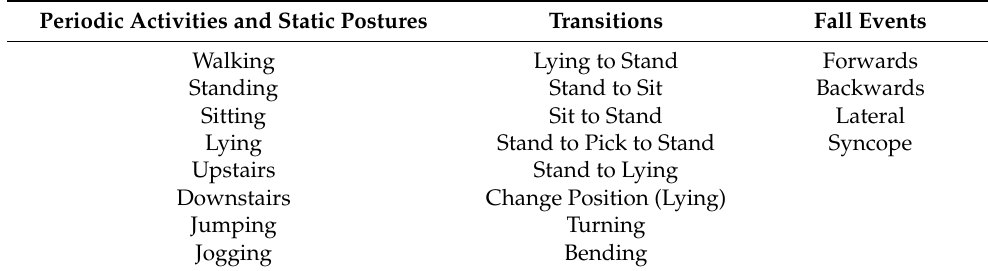
Table 3. Static postures and locomotion daily activities, postural transitions and fall events selected to be recognized by the Machine and Deep Learning